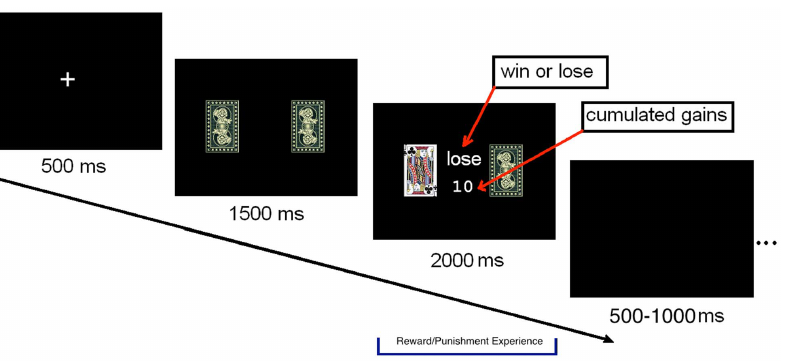
Figure 1. The timeline of one trial in present task. First, the backsides of two playing cards were shown and participants were asked to choose either the right or the left card with a button press. After 1.5 s the selected card was turned over and displayed for another 2 s. Depending on the color of the card the participant either won (red playing cards, including the heart and diamond J, Q, K) or lost (black playing cards; including the spade and club J, Q, K) 10 Yuan.